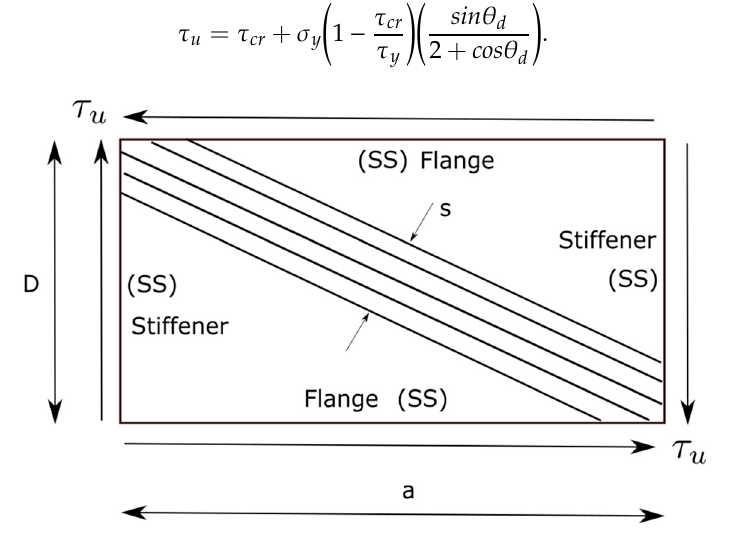
Figure 3. Schematic of Basler’s tension field theory model [5] .